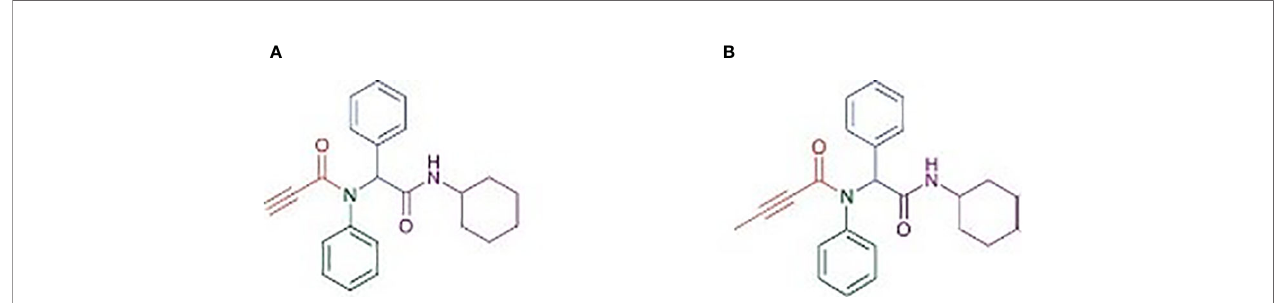
FIGURE 1 | Structure of a -amino amide analogs (RS)-N-(2-(Cyclohexylamino)-2-oxo-1-phenylethyl)-N-phenylpropiolamide (A) and (RS)-N-(2-(Cyclohexylamino)-2- oxo-1-phenylethyl)-N-phenylbut2-enamide (B) , synthesized using linear Ugi multicomponent reaction (batch reaction